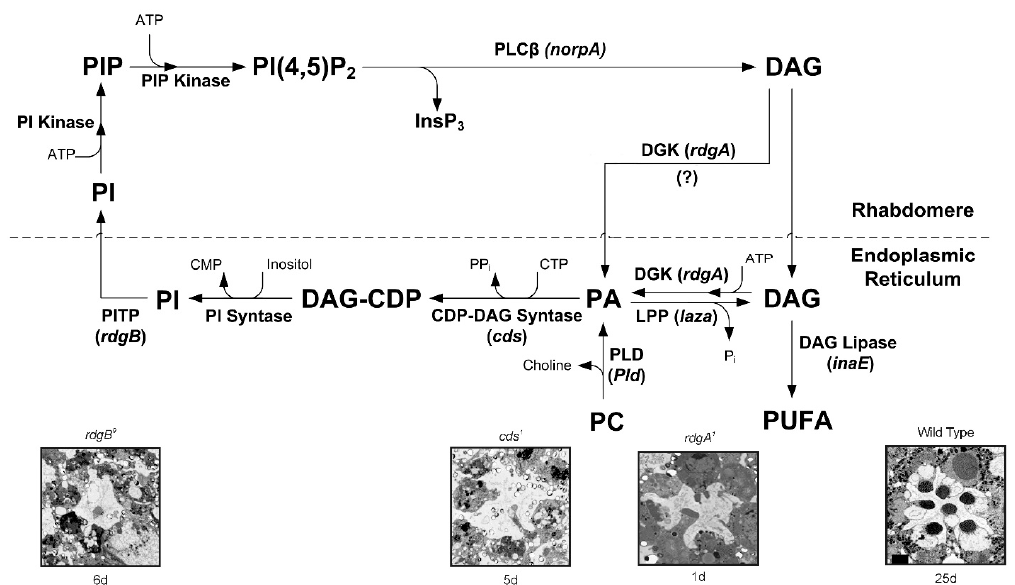
Figure 2. The phosphoinositide cycle in Drosophila photoreceptors. In the phototransduction cascade, light triggers the activation of PLC β . This catalyzes hydrolysis of the membrane PIP 2 into water-soluble InsP 3 and membrane-bound DAG. The continuous functionality of the photoreceptors during illumination is maintained by rapid regeneration of PIP 2 in a cyclic enzymatic pathway (the PI cycle). DAG is transported by endocytosis to the endoplasmic reticulum (SMC) and inactivated by phosphorylation into PA via DGK. DGK may also be localized in the rhabdomeres. PA is converted to CDP–DAG via CDP-DAG syntase (encoded by the cds gene). PA can be converted back to DAG by lipid phosphate phosphohydrolase (LPP; also designated phosphatidic acid phosphatase (PAP) encoded by laza ). PA is also produced from PC by PLD (encoded by Pld ). DAG is hydrolyzed by DAG lipases, leading to the generation of PUFA. However, for PUFA generation, either an sn-2 DAG lipase or an additional enzyme (mono-acyl glycerol (MAG) lipase) would be required, but there is no evidence of either in Drosophila photoreceptors. Nevertheless, sn-1 type DAG lipase (encoded by inaE ) was isolated. This DAG lipase was predominantly localized outside the rhabdomeres. The above difficulties put in question the participation of PUFA in channel activation in vivo. Subsequently, CDP-DAG is converted into phosphatidyl inositol (PI), which is transferred back to the microvillar membrane, by the PITP (encoded by the rdgB gene). Both RDGA and RDGB proteins have been immunolocalized to the SMC at the base of the rhabdomere. PIP and PIP 2 are produced at the microvillar membrane by PI kinase and PIP kinase, respectively. Bottom: The ultrastructure of highly degenerated ommatidia induced by three mutations in the genes rdgB, cds, rdgA , which appear in the upper scheme: and wild type for a comparison. (Modified from [43]).